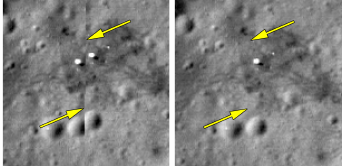
Figure 5. The boundary (yellow arrows) between the left and right frames of a mosaicked NAC pair before (left) and after (right) the relative correction.